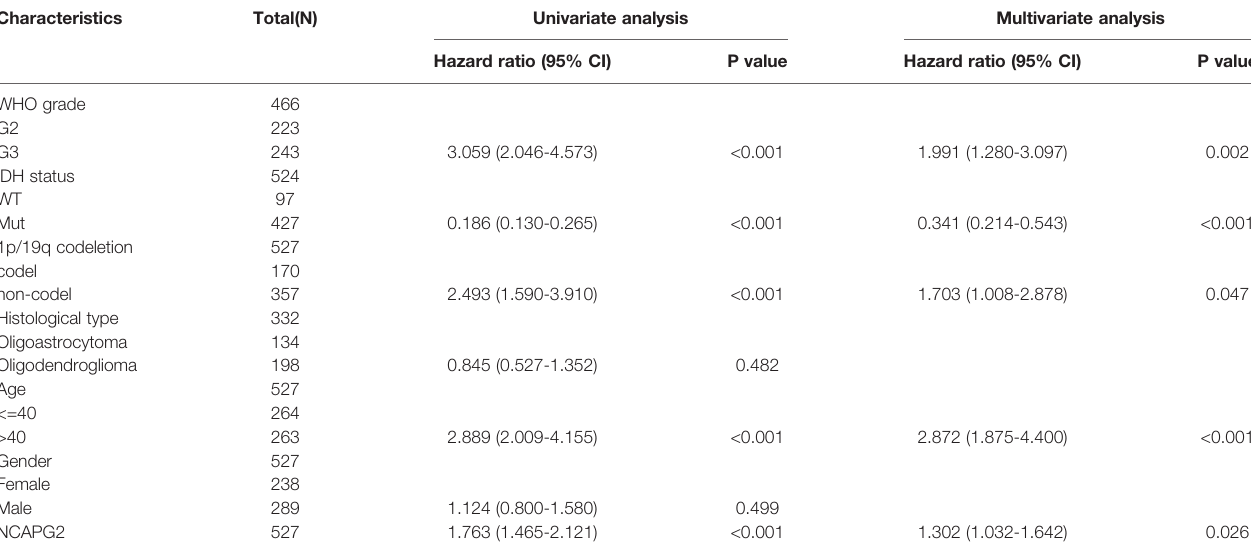
TABLE 3 | Examine the prognosis of NCAPG2 in LGG patients analysis by cox regression.